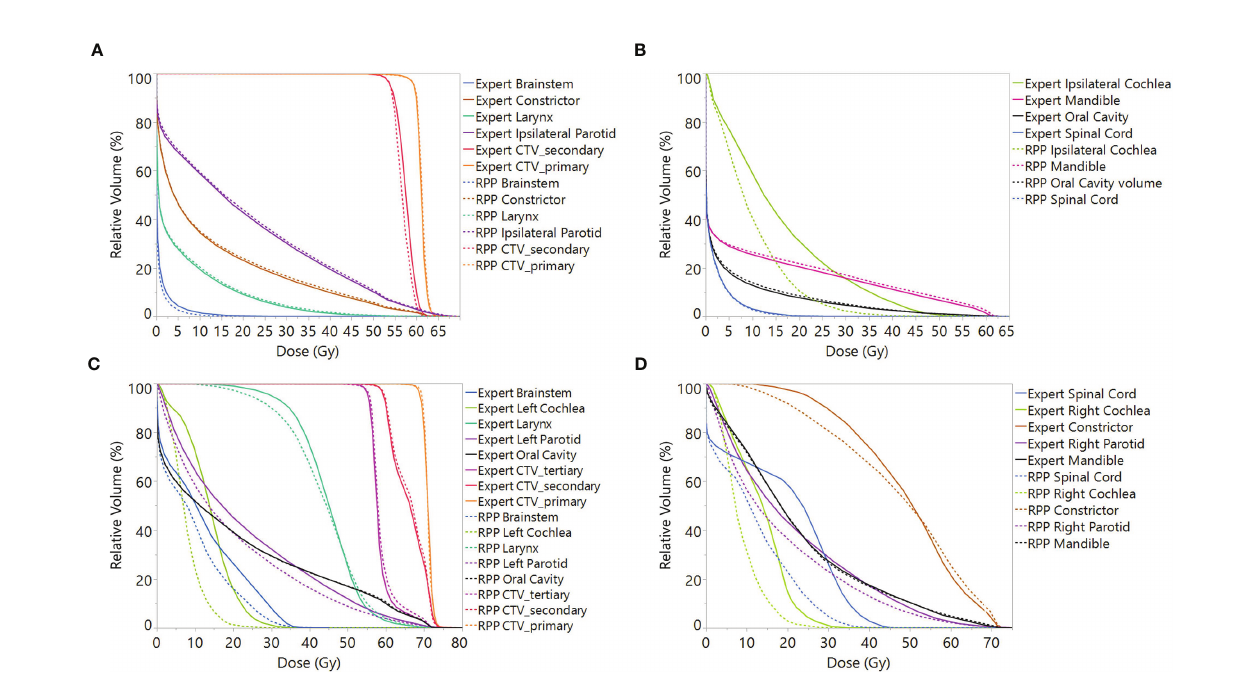
FIGURE 3 | Mean DVH including all scenarios over validation patients for (A, B) unilateral cases and (C, D) bilateral cases. Note: In order to average the CTV DVH over all patients, for each unilateral case, the DVH of CTV_primary was normalized to V60Gy = 95%, and the DVHs of CTV_secondary was normalized to V54Gy = 95%, while for bilateral cases, the CTV_secondary was normalized to V60Gy = 95%. DVH, dose – volume histogram; CTV, clinical treatment volume.